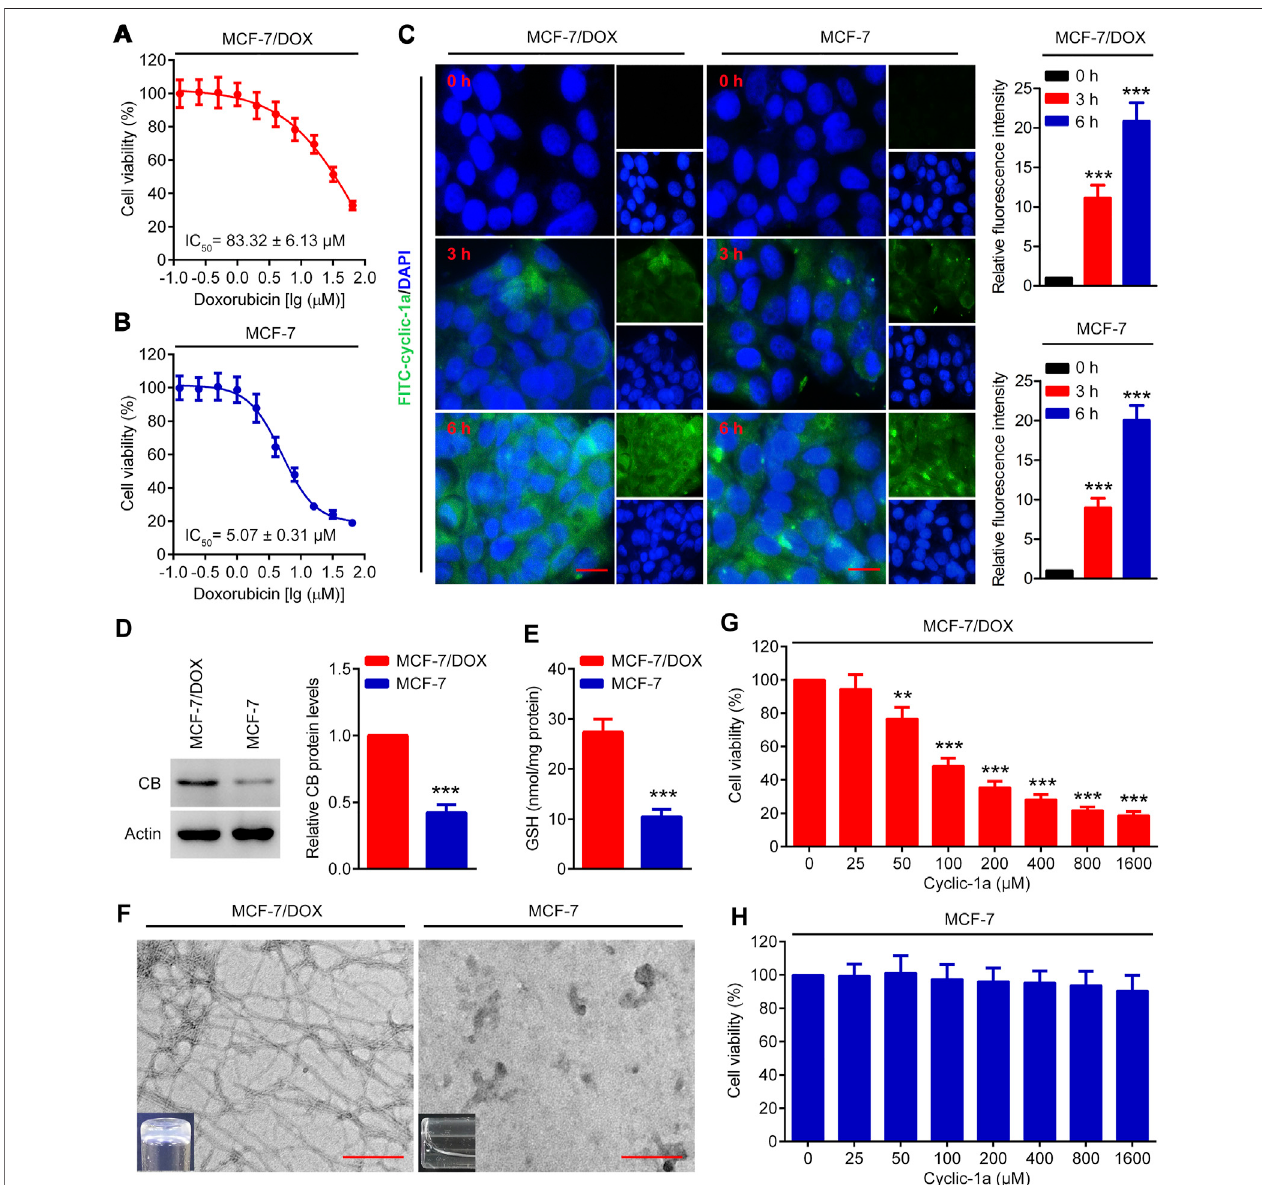
FIGURE 3 | The cytotoxicity effects of cyclic-1a on MCF-7/DOX and MCF-7 cells. (A – B) The cytotoxicity effects of DOX on MCF-7/DOX and MCF-7 cells were detected by using MTT assay. (C) The cellular uptake ability of cyclic-1a. The images of MCF-7 and MCF-7/DOX cells treated with FITC-cyclic-1a. Scale bar (cid:1) 10 μ m. (D) The levels of CB in MCF-7/DOX and MCF-7 cells were detected by using western blot analysis. *** p < 0.001 vs MCF-7/DOX cells. (E) Intracellular GSH levels in MCF-7/DOX and MCF-7 cells. *** p < 0.001 vs MCF-7/DOX cells. (F) TEM observation and gelation test of the lysates of MCF-7/DOX and MCF-7 cells treated with 1,600 μ M of cyclic-1a for 72 h (Scale bar (cid:1) 200 nm). (G – H) The cytotoxicity effects of cyclic-1a on MCF-7/DOX and MCF-7 cells were detected by using MTT assay. ** p < 0.01, *** p < 0.001 vs 0 μ M of cyclic-1a group. Data are represented as mean ± SD, n (cid:1) 3.